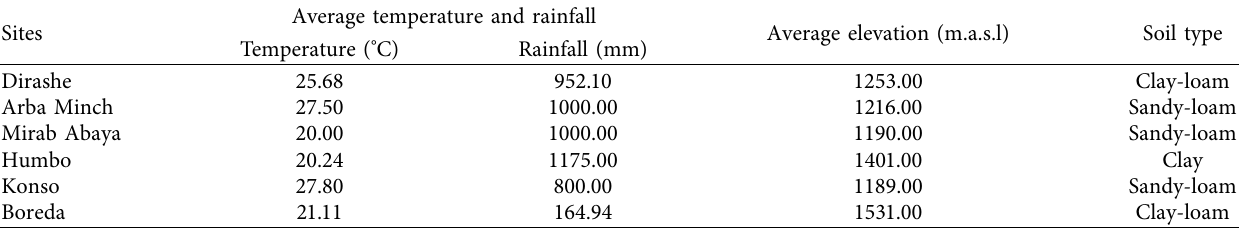
Table 1: Description of the study locations.